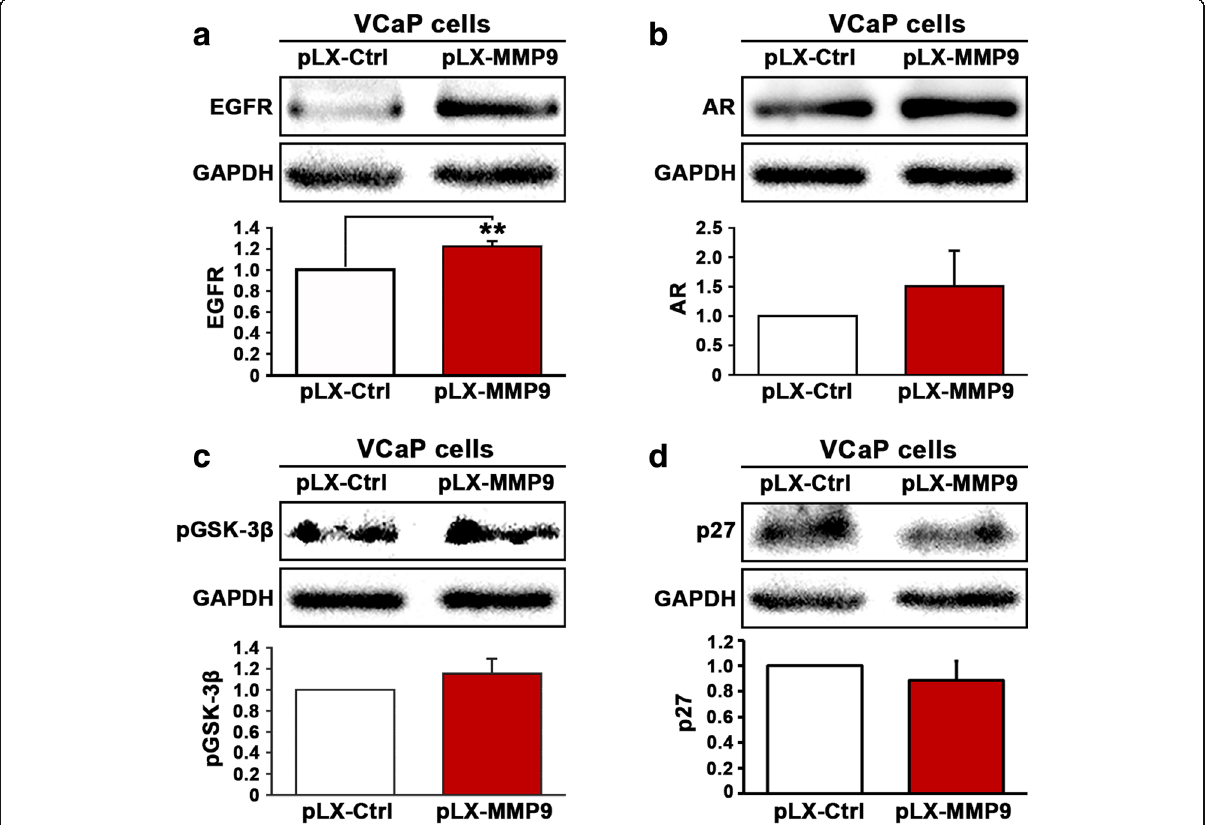
Fig. 5 The effect of overexpression of MMP9 on the expression of EGFR, AR, p-GSK-3 β and p27 in VCaP cells. a Immunoblot analysis was performed to examine the expression of EGFR in VCaP cells that were transfected with pLX-control vector (PLX-Ctrl) or pLX-MMP9 vector (PLX-MMP9). b Expression of AR in VCaP cells that were transfected with pLX-control vector (PLX-Ctrl) or pLX-MMP9 vector (PLX-MMP9). c and d Expression of p-GSK-3 β and p27 in VCaP cells that were transfected with pLX-control vector (PLX-Ctrl) or pLX-MMP9 vector (PLX-MMP9). Data presented is average of two independent experiments (±SD). p <0.05 is indicated by “ * ” , p ≤ 0.01 is indicated by “ **